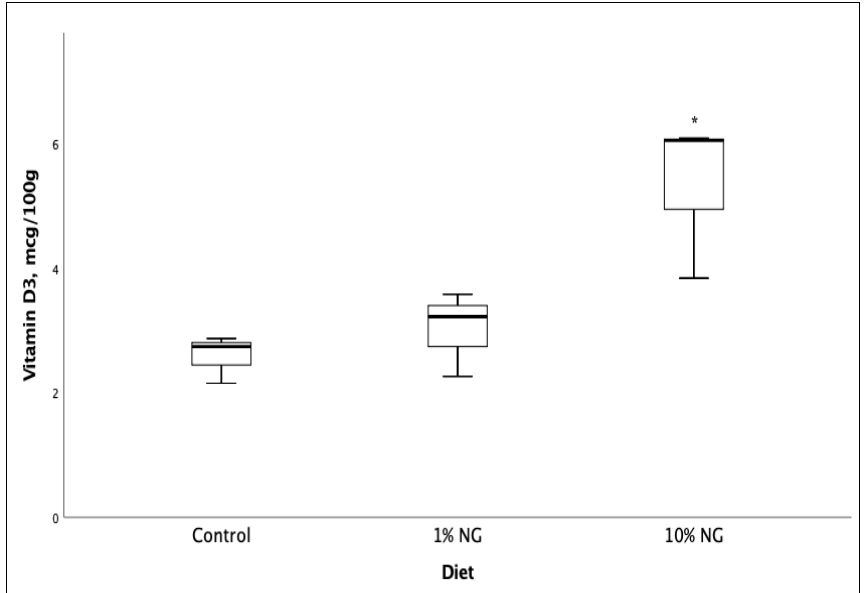
Figure 1. Salmon meat vitamin D 3 composition after 49 days of feeding the experimental diets. NG = Nannochloropsis gaditana , *Significantly different from control ( p < 0.05) Values are based on the mean ± S.D. n = 5.